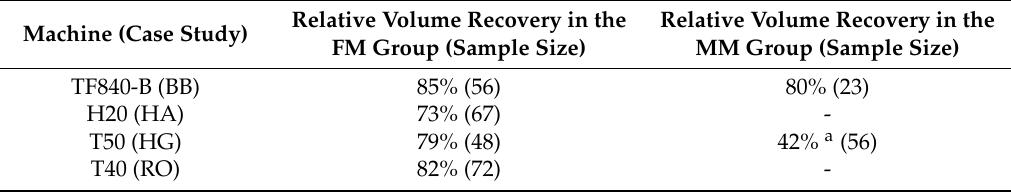
Table 9. Relative volume recovery in the different case studies, calculated as ratio of product volume (recovered volume under bark) and tree volume (merchantable volume on bark).